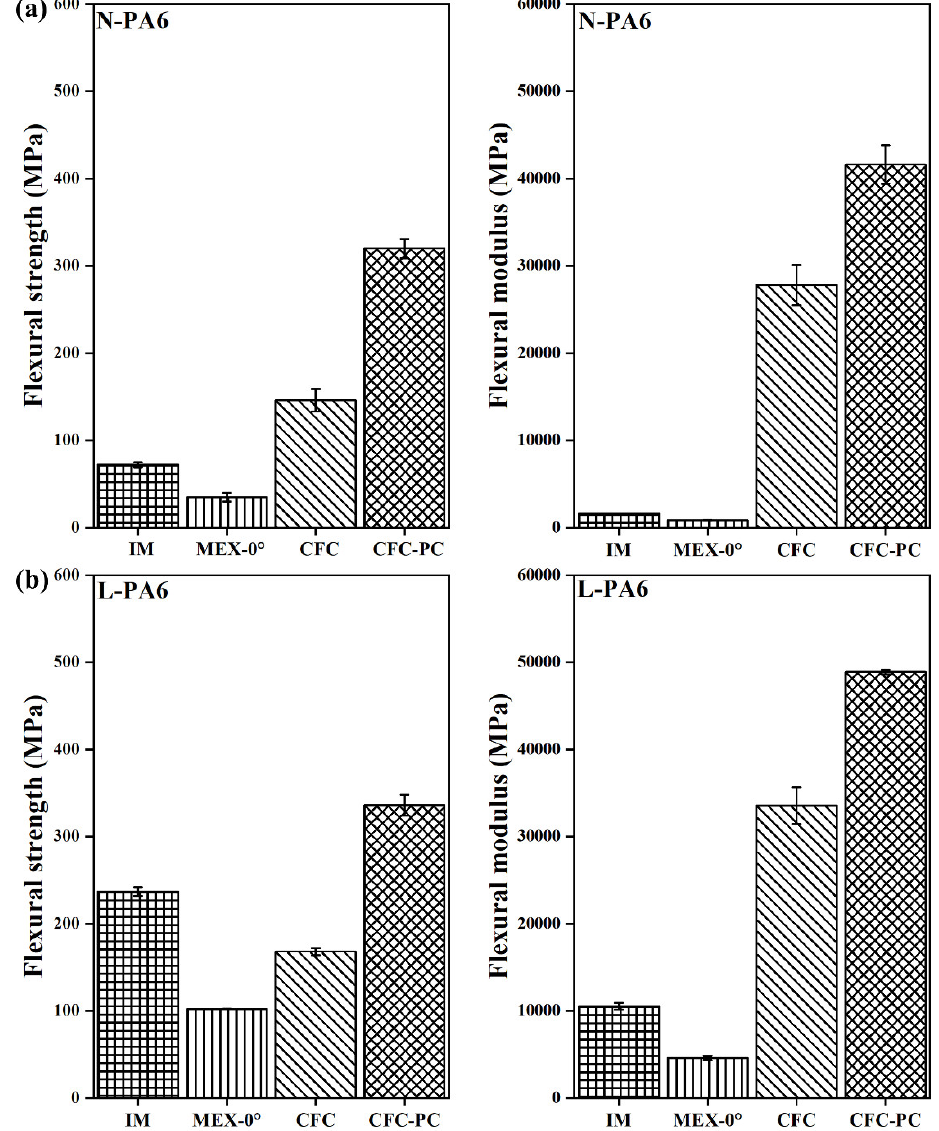
Figure 8. Flexural test data of PA6 with a corresponding error bar. Where, N-PA6 is neat PA6 and L PA6 is long carbon fibre reinforced PA6. The corresponding IM, MEX-0 ◦ , CFC, and CFC-PC are injection moulded, 3D printed, composite filament co-extruded, and post-processed composite filament co-extruded 3D printed 4-pointing beding tested specimens,